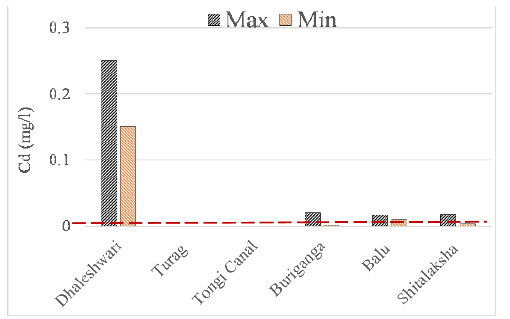
Figure 10. Concentrations for Cd in the peripheral rivers of Dhaka with WHO standard in dotted line (0.003 mg/L).